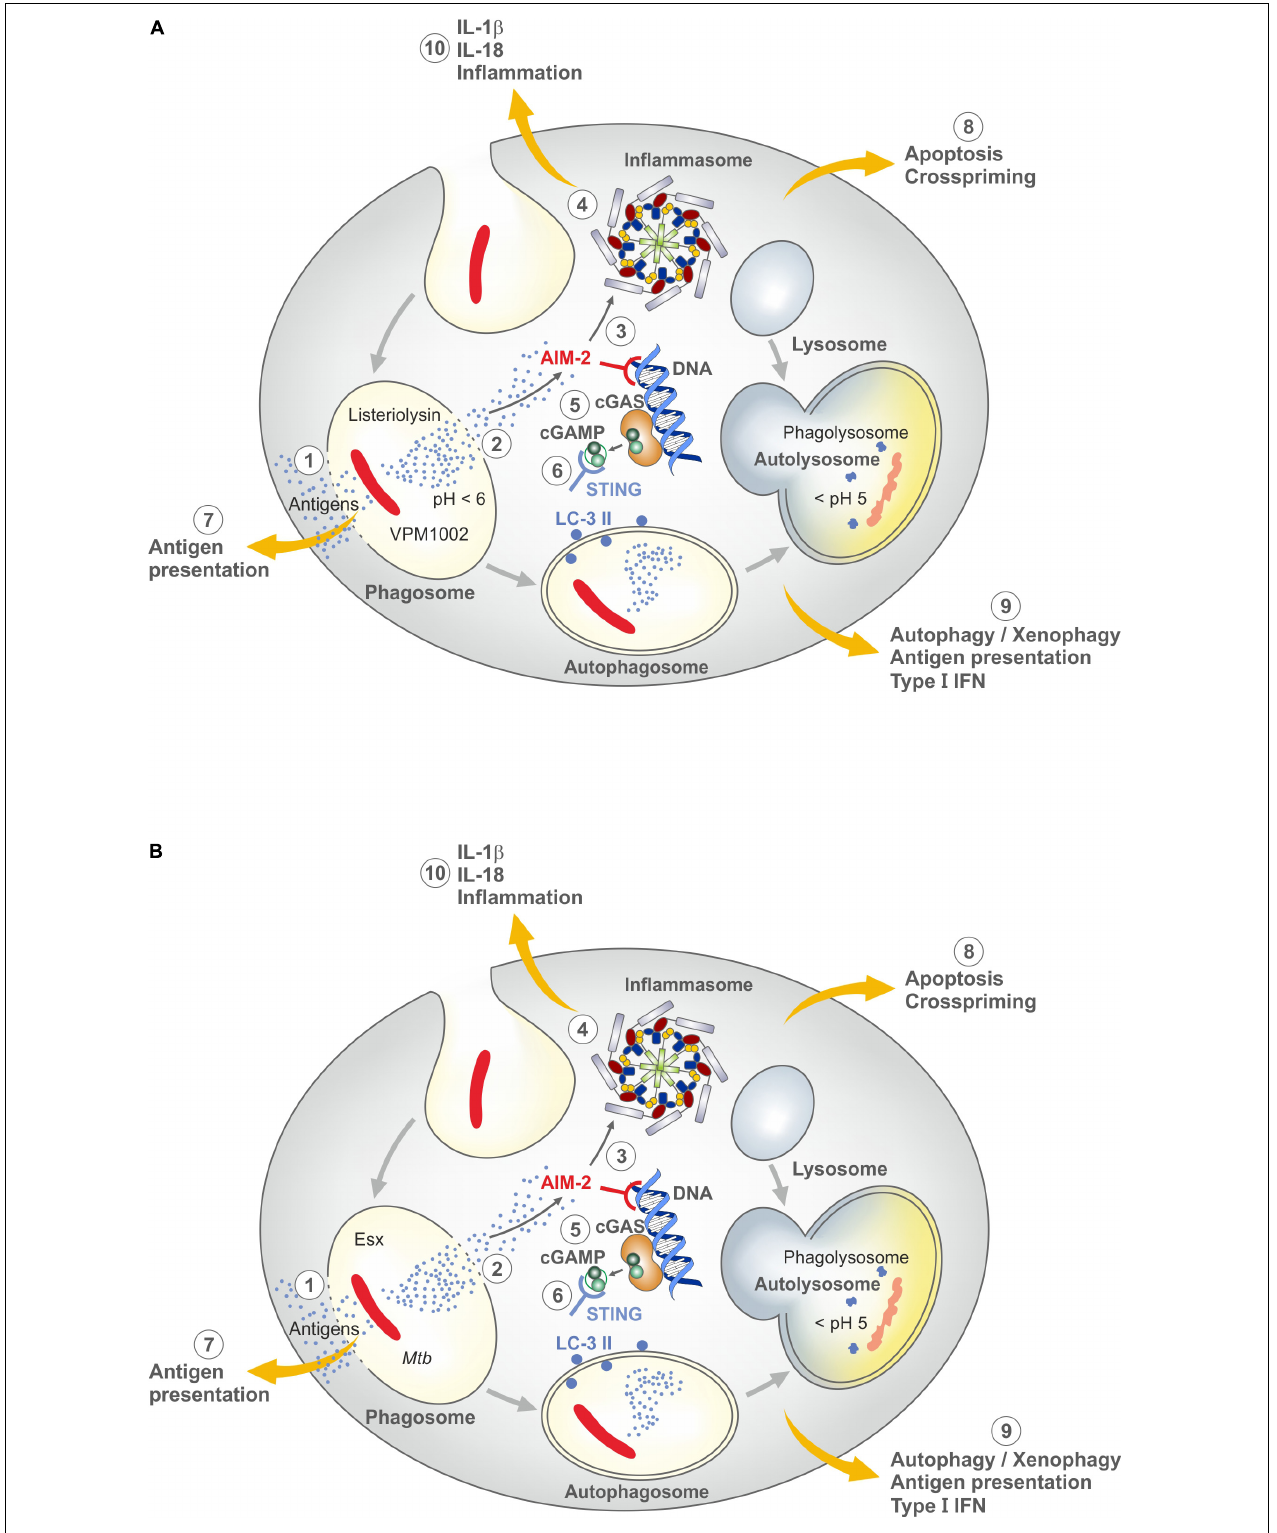
FIGURE 2 | Major mechanisms underlying induction of the host immune response by VPM1002 and M. tuberculosis ( Mtb ) (for further details see text). (A) VPM1002. VPM1002 (rBCG (cid:49) ureC::Hly) expresses listeriolysin and lacks urease C activity. Following phagocytosis, VPM1002 ends up in a phagosome. Principally